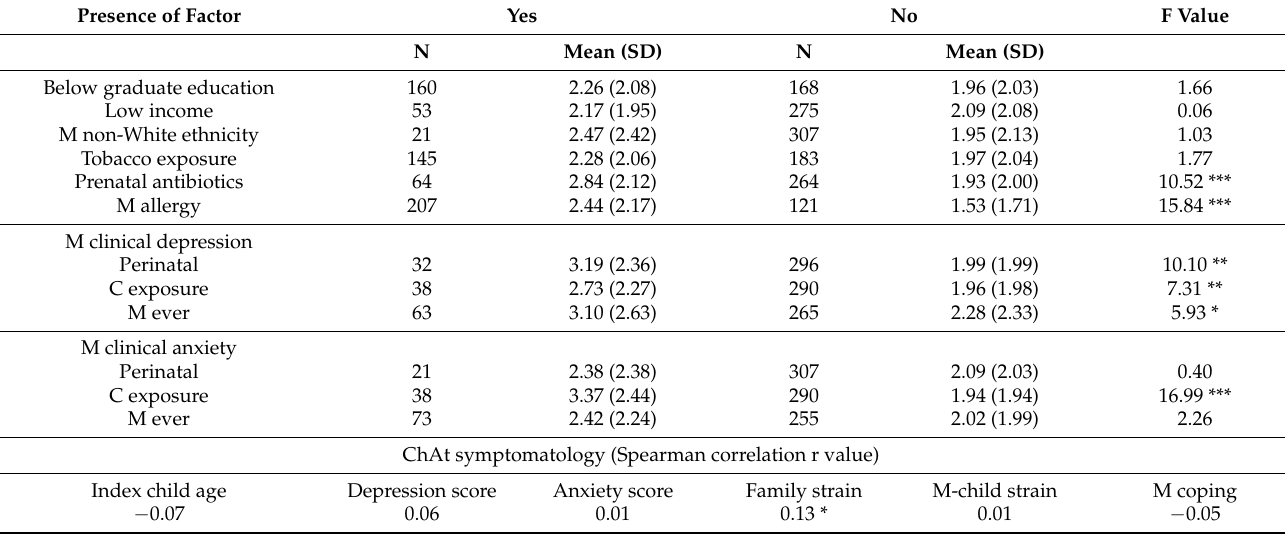
Table 2. Child allergy symptomatology in relation to maternal mental health, family strain, and sociodemographic and health characteristics: ANOVA and correlations (N = 328).